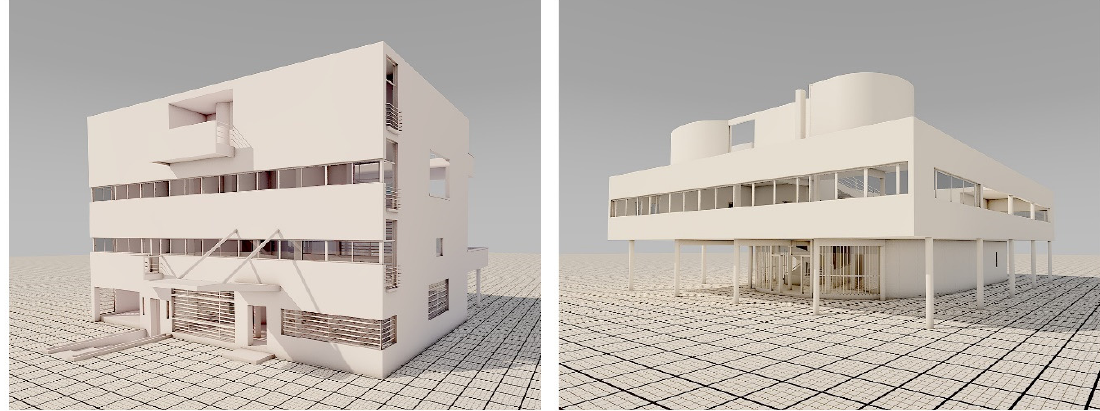
Figure 2. Perspective views of Le Corbusier’s Villa Stein ( left ) and Villa Savoye ( right ).